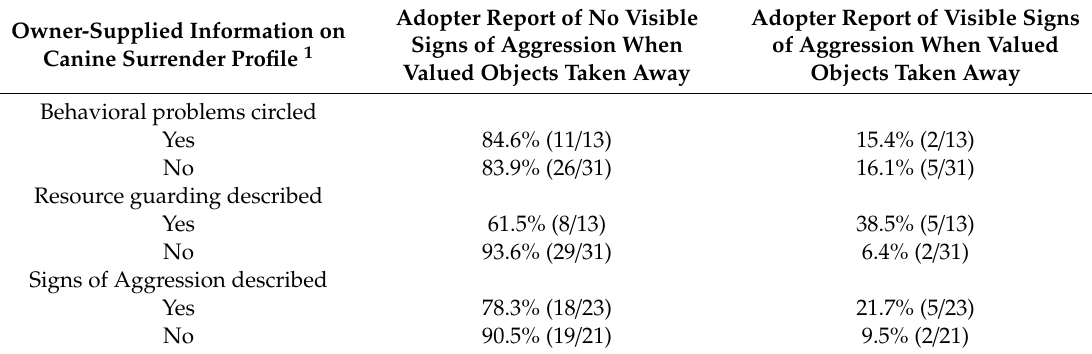
Table 6. Relationship between owner-supplied information at the time of canine surrender to the shelter and adopter reports of resource guarding behavior in the new home when toys, bones, or other valued objects were taken away (Q1 on the adopter